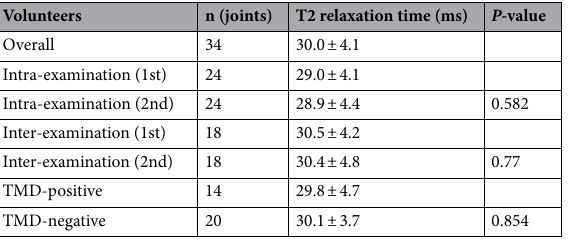
Table 3. T2 relaxation times of the retrodiscal tissue. TMD, temporomandibular